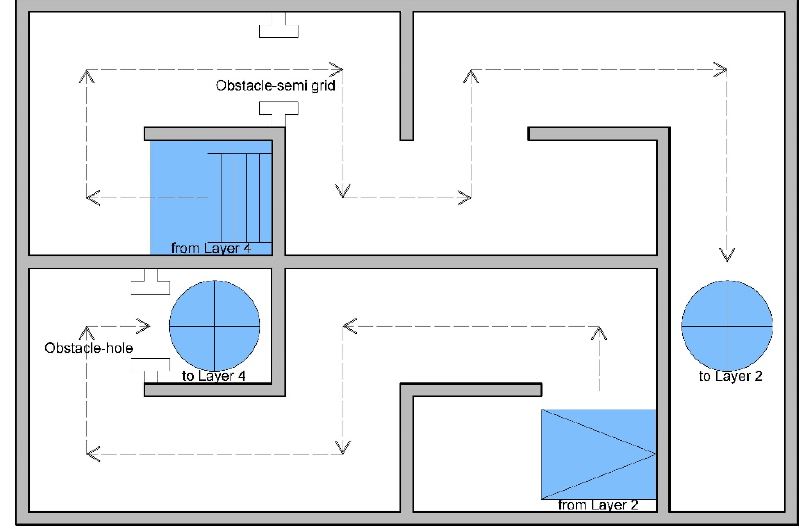
Figure 5. Floor plan for Layer 3.